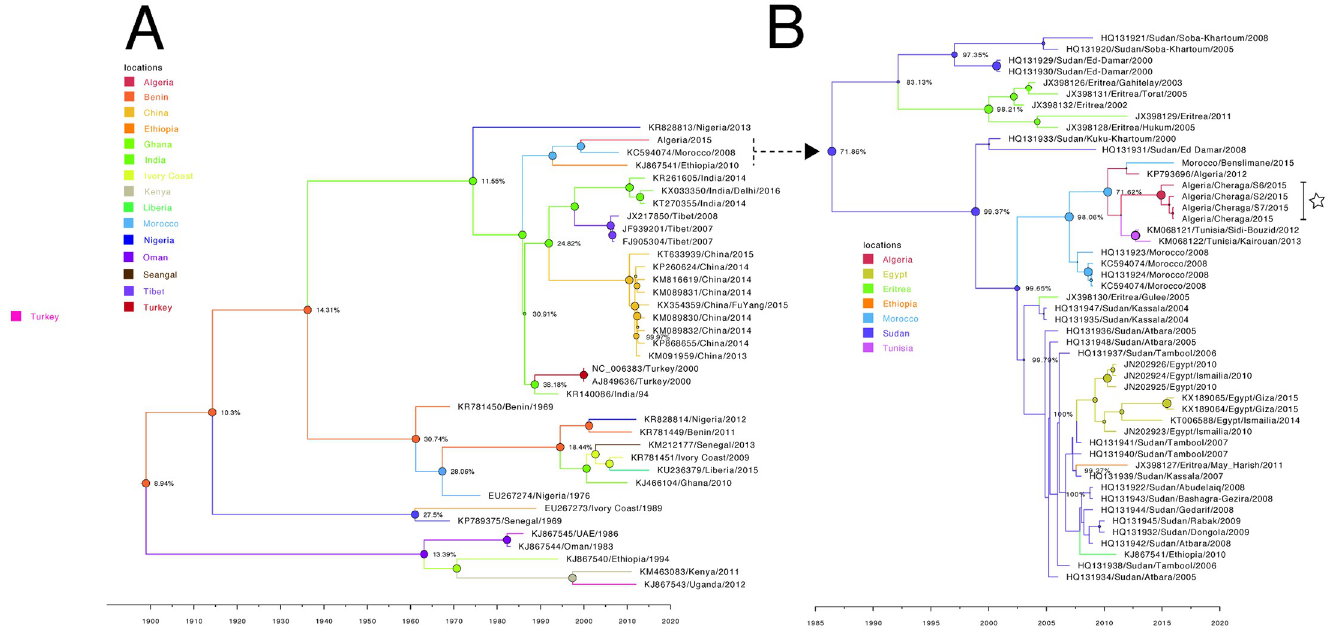
Fig 6. Maximum clade credibility trees constructed for the phylogeographical reconstruction of PPRV using complete genome data (A) or partial N sequences derived from North or East Africa (B). Posterior probabilityvalues are indicatedby the size of the node and posterior probability distribution indicatedas a percentageat the size of each node. Branches are colored accordingto most likely locationat the preceding node. Horizontal axis indicatestime in years. Samples for which have beensequencedin this study are highlightedby a white star. GenBank accessionnumbers are given againsteach sequencewhere